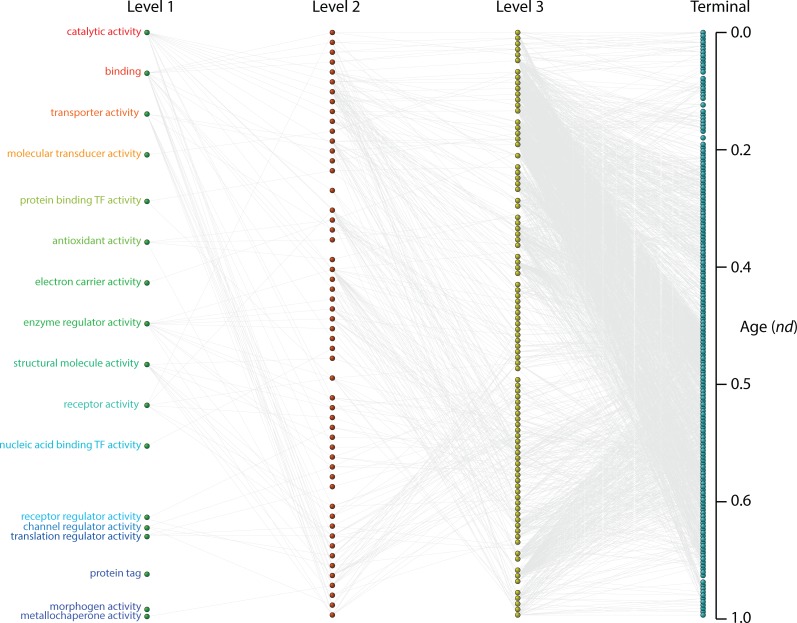
A gene ontology network inferred from age (nd) and hierarchy of terms.The diagram shows a large networks of molecular functions and their interrelationships. The GO terms were sorted by nd value in the y axis. Green circles: level 1 (17 GO terms); orange circles: level 2 (101 GO terms); yellow circles: level 3 (257 GO terms) and, cyan circles: terminal GO terms (1891 GO terms). Many GO terms overlapped in the network. The network was created with the Pajek program.